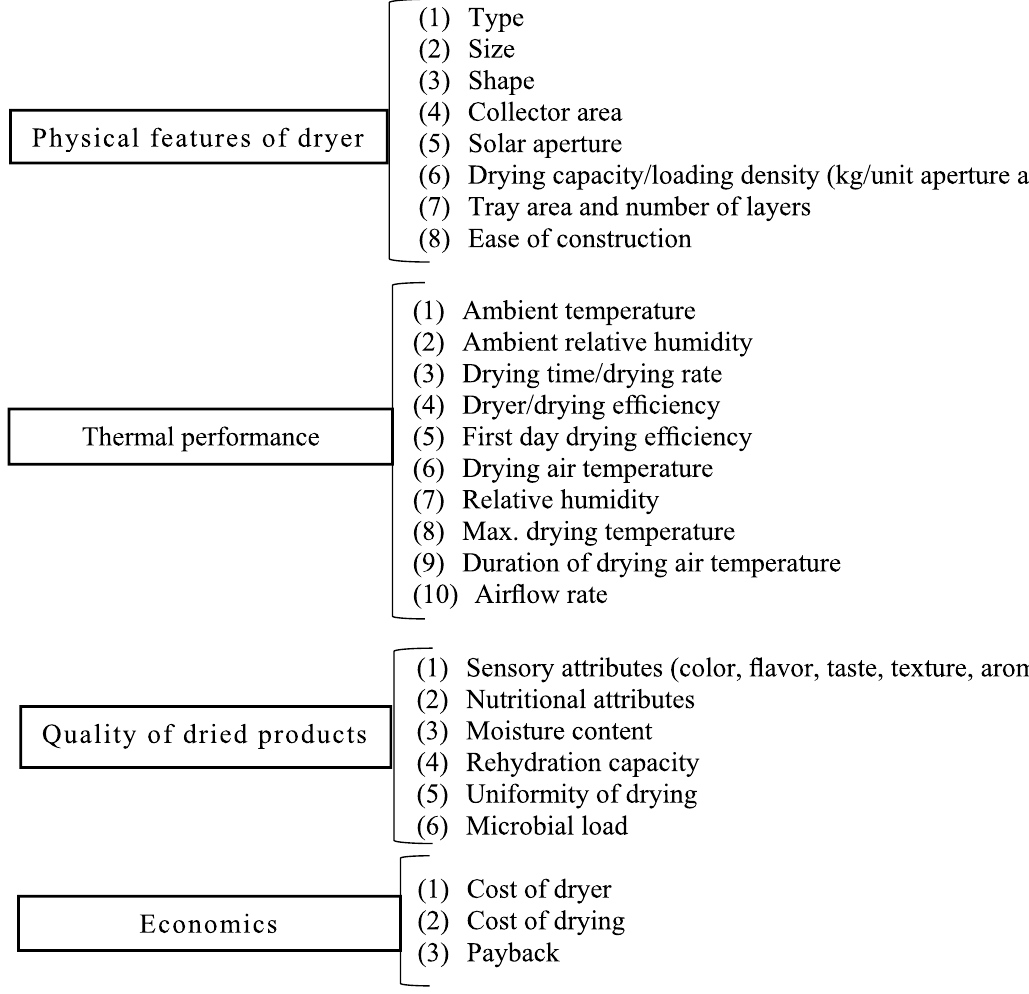
Fig. 2 Solar dryer evaluation parameters adapted from Leon and Kumar [63] and Masud et al.,